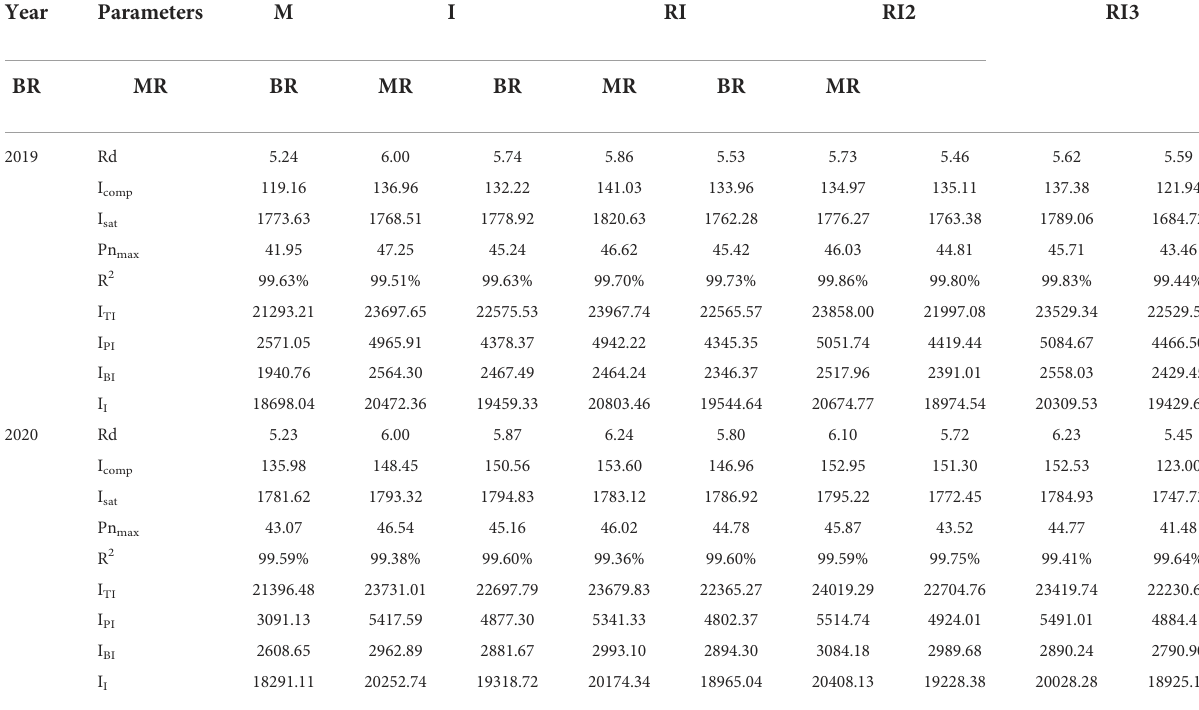
TABLE 3 The chlorophyll fl uorescence characteristics of